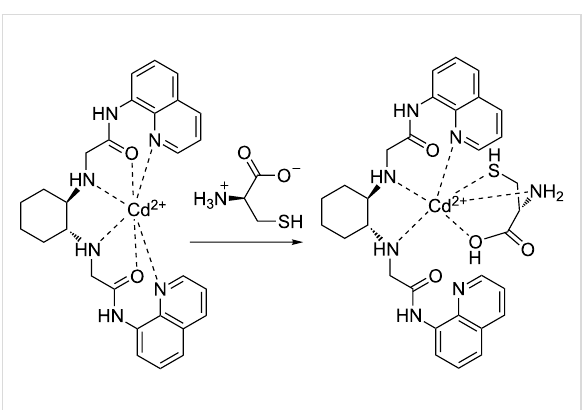
Figure 10: Proposed binding model of Cd 2+ – ACAQ with cysteine.